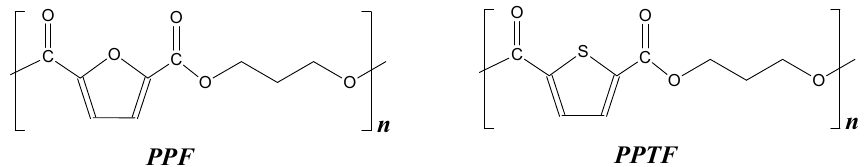
Figure 1. Poly(propylene 2,5-furandicarboxylate) (PPF) and poly(propylene 2,5-thiophendicarboxylate) (PPTF) chemical structure.